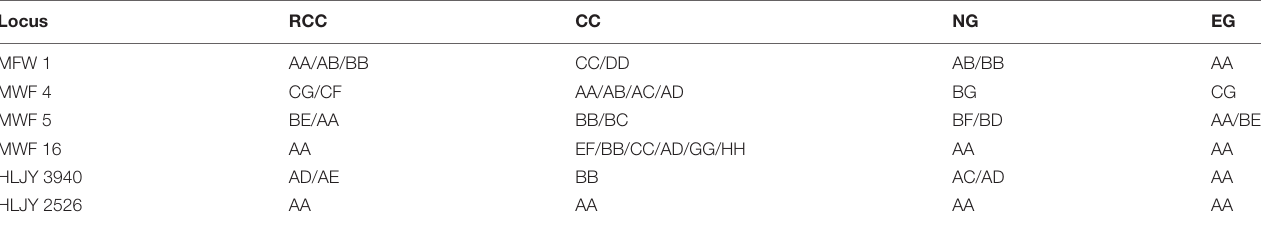
Capital letters correspond to allele types at each